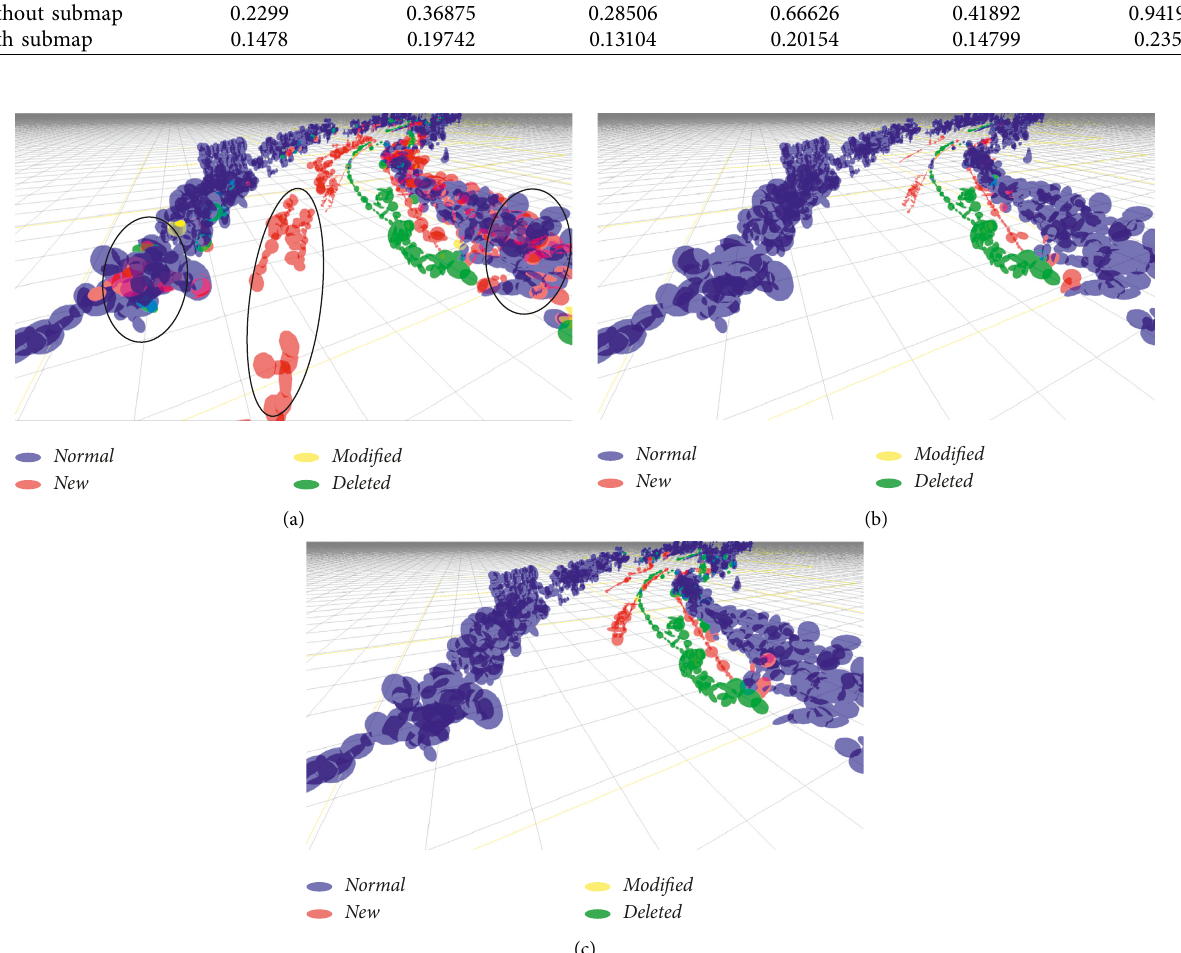
Figure 20: Map change information (a) detected by the map change detection algorithm based on single driving, (b) updated by the proposed framework based on crowd-sourced data, and (c) representing ground truth